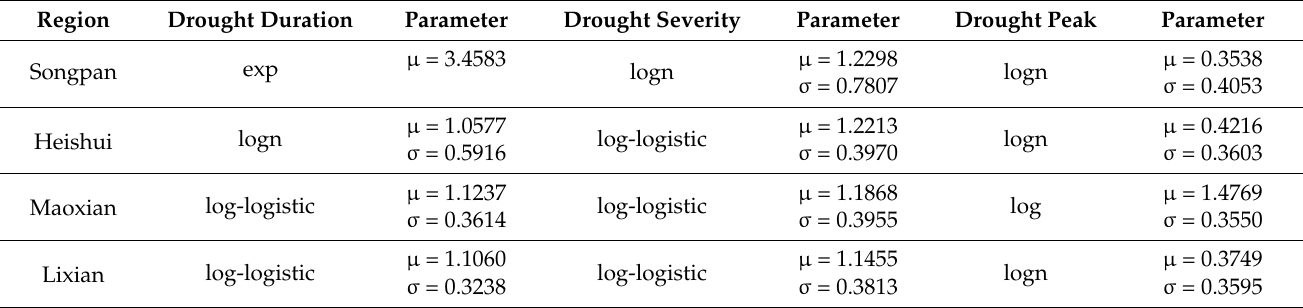
Table 4. Marginal distribution of drought characteristics in each